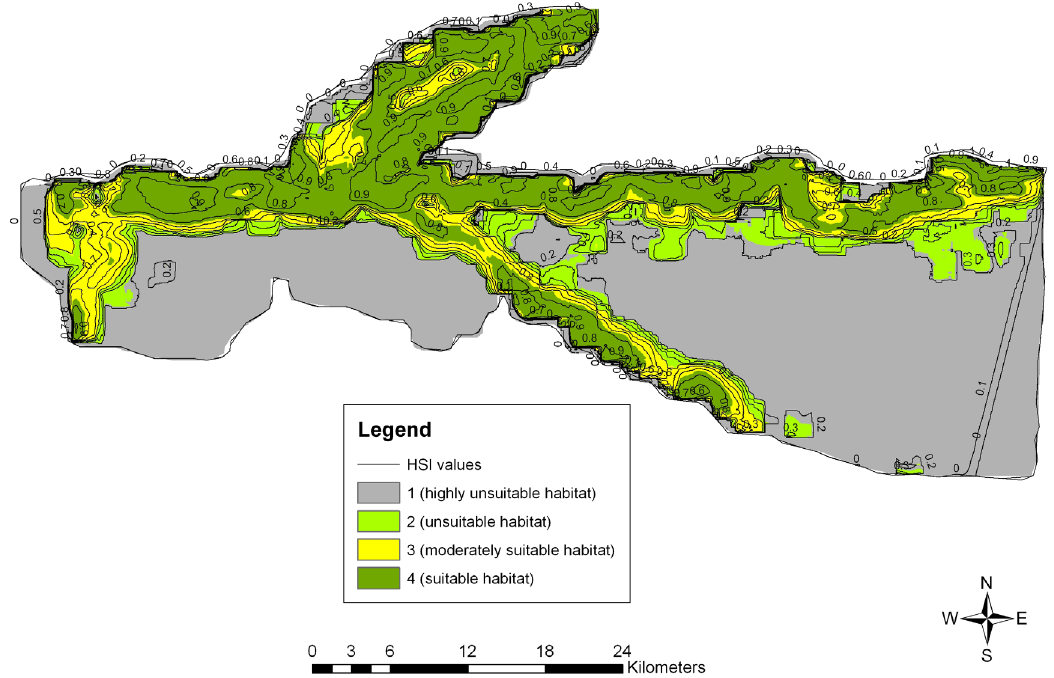
Figure 5. Habitat Suitability Index